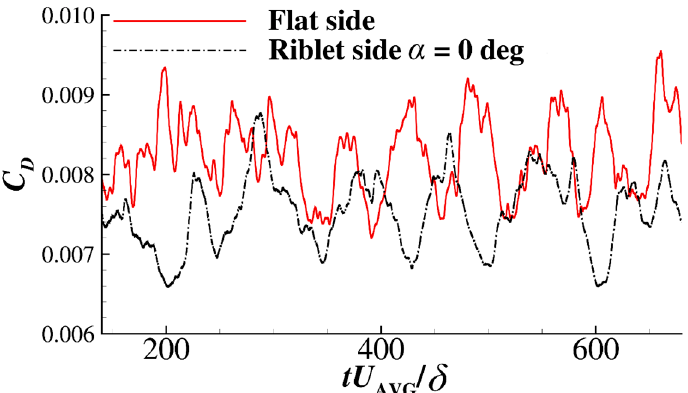
Figure 3. Histories of the drag coefficient for the α = 0° case.